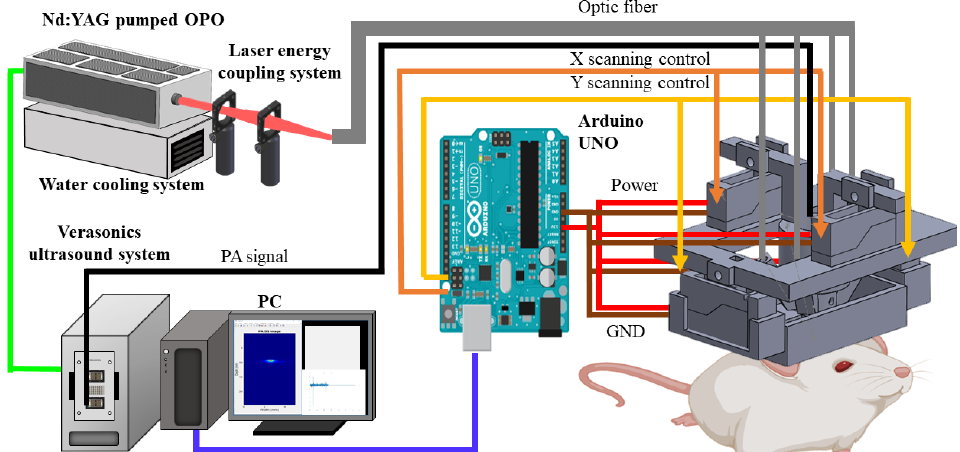
Figure 1. Diagram of the head ‐ mounted hmPAI system with fiber ‐ bundle ‐ based illumination. First, the laser system provides laser pulses to the optical fiber through the lens, and the optical fiber is connected to the hmPAI device. The hmPAI device is mainly composed of four linear motors and controlled by the developed Arduino system. The holder was made by light ‐ cured 3D printing. In the PC base, we used our own designed interface to control the entire imaging and scanning system.